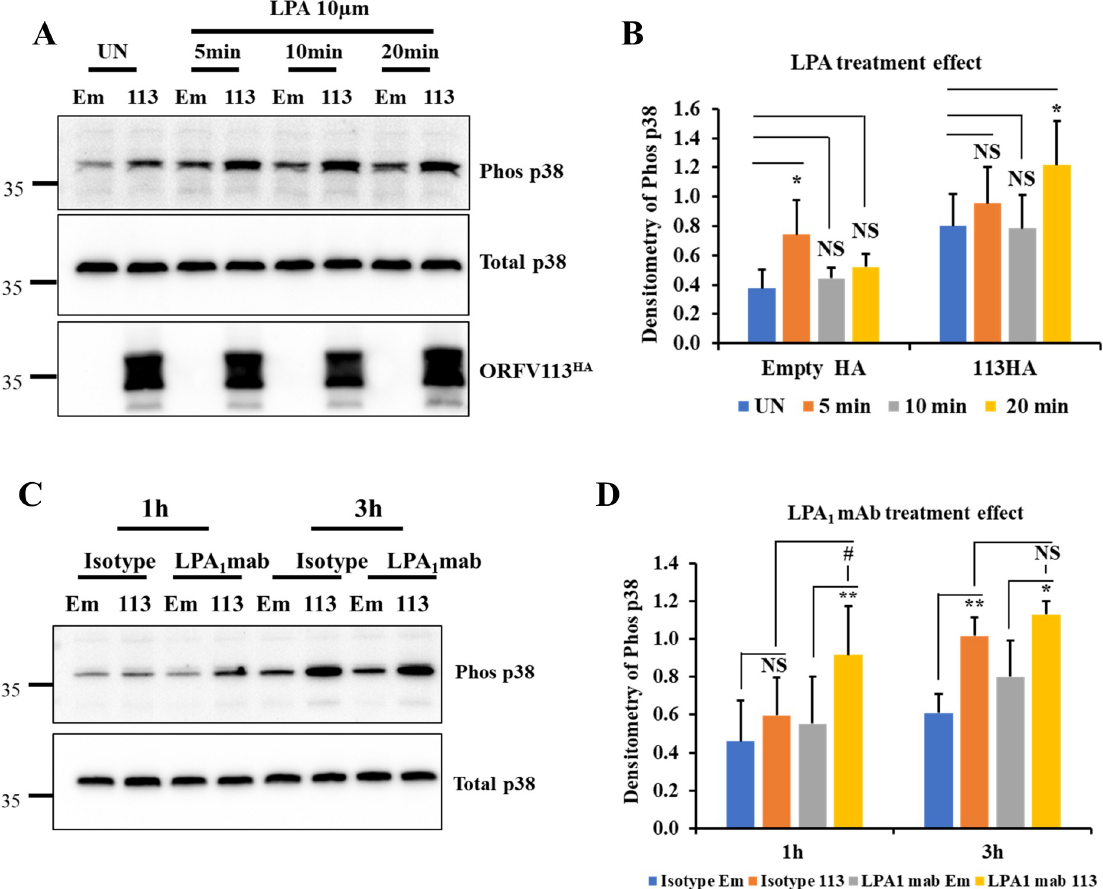
Fig 8. Treatment with LPA and antibody against LPA 1 enhances ORFV113 induced p38 phosphorylation. (A and B) LPA treatment enhances ORFV113 induced p38 phosphorylation. OFTu cells transfected with plasmids pCMV-HA or pORFV113 HA for 5 h were induced with LPA harvested at 5, 10 and 20 min. Total cell protein extracts were resolved by SDS-PAGE, blotted and incubated with antibodies against phos-p38, total p38, HA and GAPDH. (B) Densitometry of phos-p38 bands were normalized to total p38 (loading control). Results are average of four independent experiments. Error bars represent mean ± SD. Statistical analysis was performed using one-way ANOVA with post hoc Tukey test for multiple comparisons ( � , P < 0 . 05 ; �� , P < 0 . 01 , NS : non-significant ). (C and D) Antibody against LPA 1 enhances ORFV113 induced p38 phosphorylation. OFTu cells pretreated with isotype control or LPA 1 monoclonal antibody (10 μ g/ml) for 45 min were treated with immunoprecipitation products from pCMV-HA or pORFV113 HA expressing cells in presence of isotype control or LPA 1 monoclonal antibody (10 μ g/ml) and harvested at 1 and 3 h. Total cell protein extracts were resolved by SDS-PAGE, blotted and incubated with antibodies against phos-p38 and total p38. (D) Densitometry of phos-p38 bands were normalized as in B. Results are average of five independent experiments. Error bars represent mean ± SD. Statistical analysis was performed as described in B ( � , # , P < 0 . 05 ; �� , P < 0 . 01 ; NS : non-significant